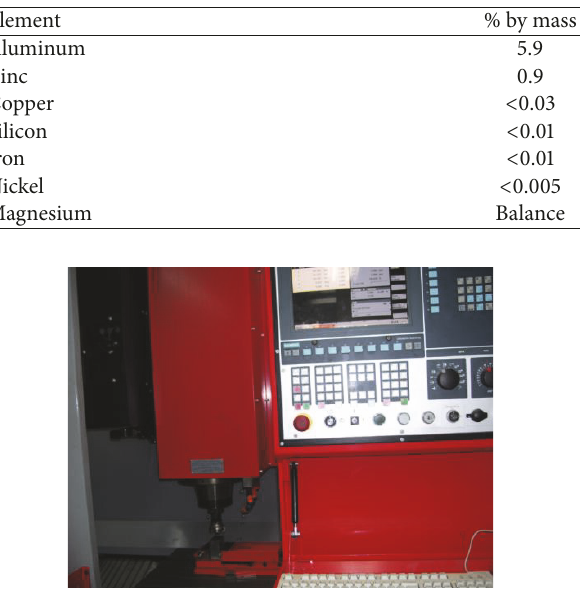
Table 1: Chemical composition of magnesium AZ 61 alloy.